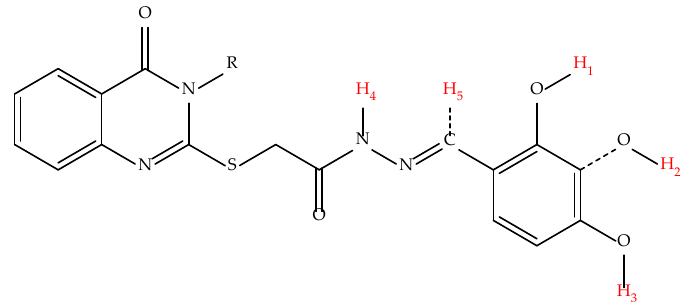
Figure 1. General structure representing the possible sites of compounds 5a – d and 6a – d to release hydrogen atoms (numbered H 1 –H 5 ) and to neutralize radicals .